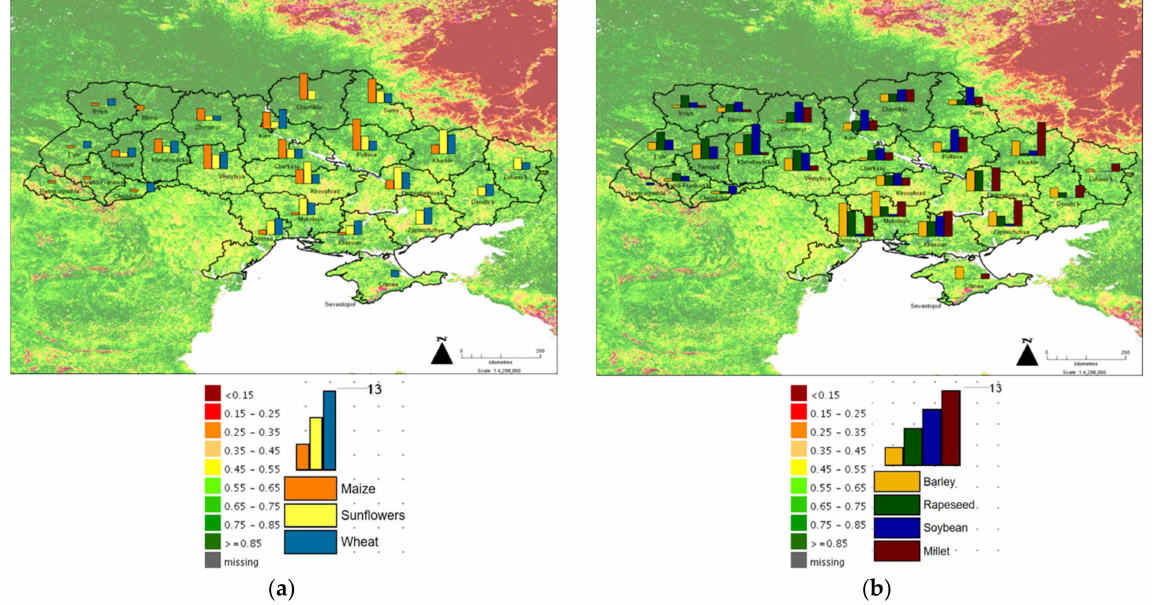
Figure 3. The March 2022 VCI and proportion of maize, sunflowers, and wheat produced in each Oblast (region) ( a ) and March 2022 VCI and proportion of barley, rapeseed, soybean, and millet produced in each Oblast ( b ). The maximum proportion of crop produced is 13% of the total and each bar is relative to this 13% maximum. Data from UNFAO and USDA FAS, analysis developed using MapInfo